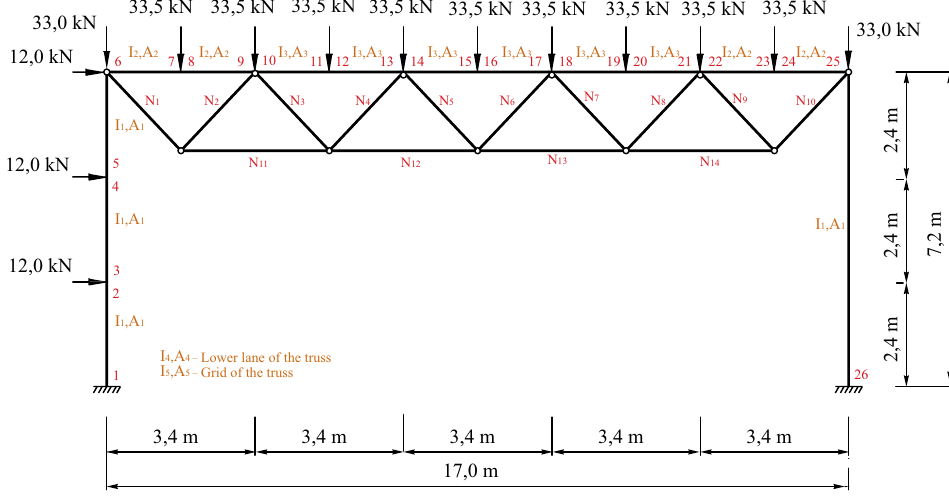
Fig. 1. Computational scheme for a steel framing structure